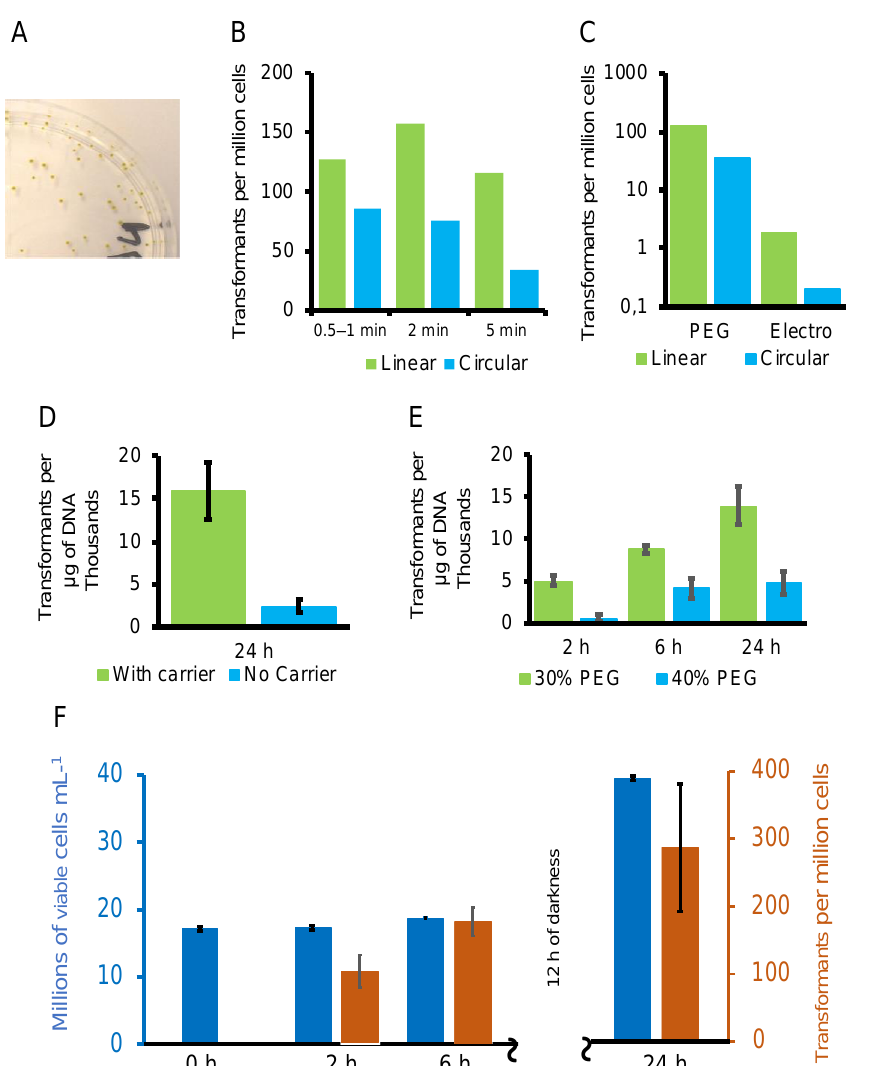
Figure 2. Optimisation of the transformation procedure. ( A ) Colonies of transformants on a Petri dish with 9 cm diameter 19 days after transformation. Linearized DNA gave 2-to-9-fold more transformants than circular DNA in five comparisons ( B , C ), 2 min incubation in the PEG + DNA transformation mix was su ffi cient (( B ), three comparisons). In ( B , C ), recovery of cells in culture after treatment with PEG was 24 h, whereas in ( D — F ), the times of recovery of cells in culture after treatment with PEG is shown along the abscissae. PEG was superior to electroporation (( C ), two comparisons, note the logarithmic scale) and carrier tRNA was advantageous (( D ), tests in four independent transformations, bars show standard deviations). At lower concentrations of transforming DNA (2 µ g) the transformation more often failed completely if there was no carrier (overall 3 / 11 tests failed with no carrier, data not shown). Either salmon sperm DNA ( B , C ) or yeast tRNA ( D — F ) were used as a carriers, except for the absence of carrier in one treatment. It was found that 30% PEG MW 4000 was better than 40% PEG MW 4000 (( E ), three tests). Panel ( F ) shows comparisons of cell cycle stage on the number of transformants on two independent vertical axes. Blue bars (left axis) show cell growth in untreated cell cultures measured at the time of the transformation experiment. Cell density showed only a small increase during the day, but doubled during the night. Brown bars (right axis) show the number of transformants found after three weeks from short (2 min) PEG / DNA treatments and with recovery periods in culture of 2, 6 or 24 h. ( B ) Addition of tRNA carrier increased transformation frequency. ( C ) Increasing the concentration of PEG MW 4000 reduced the yield of transformants. Standard deviations were calculated using the STDEV.S function in Microsoft